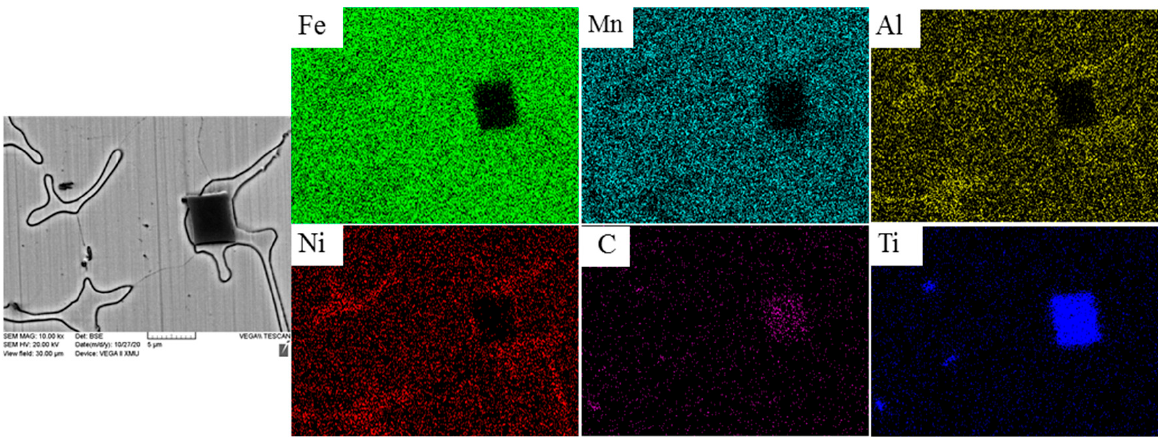
Figure 4. SEM image and element distribution of Fe-25Mn-9Al-8Ni-1C-0.4Ti alloy. To further judge the type of titanium carbon compound in the microstructure, Fe- 25Mn-9Al-8Ni-1C-0.4Ti alloy is analyzed by TEM. The corresponding Bright Field Trans-